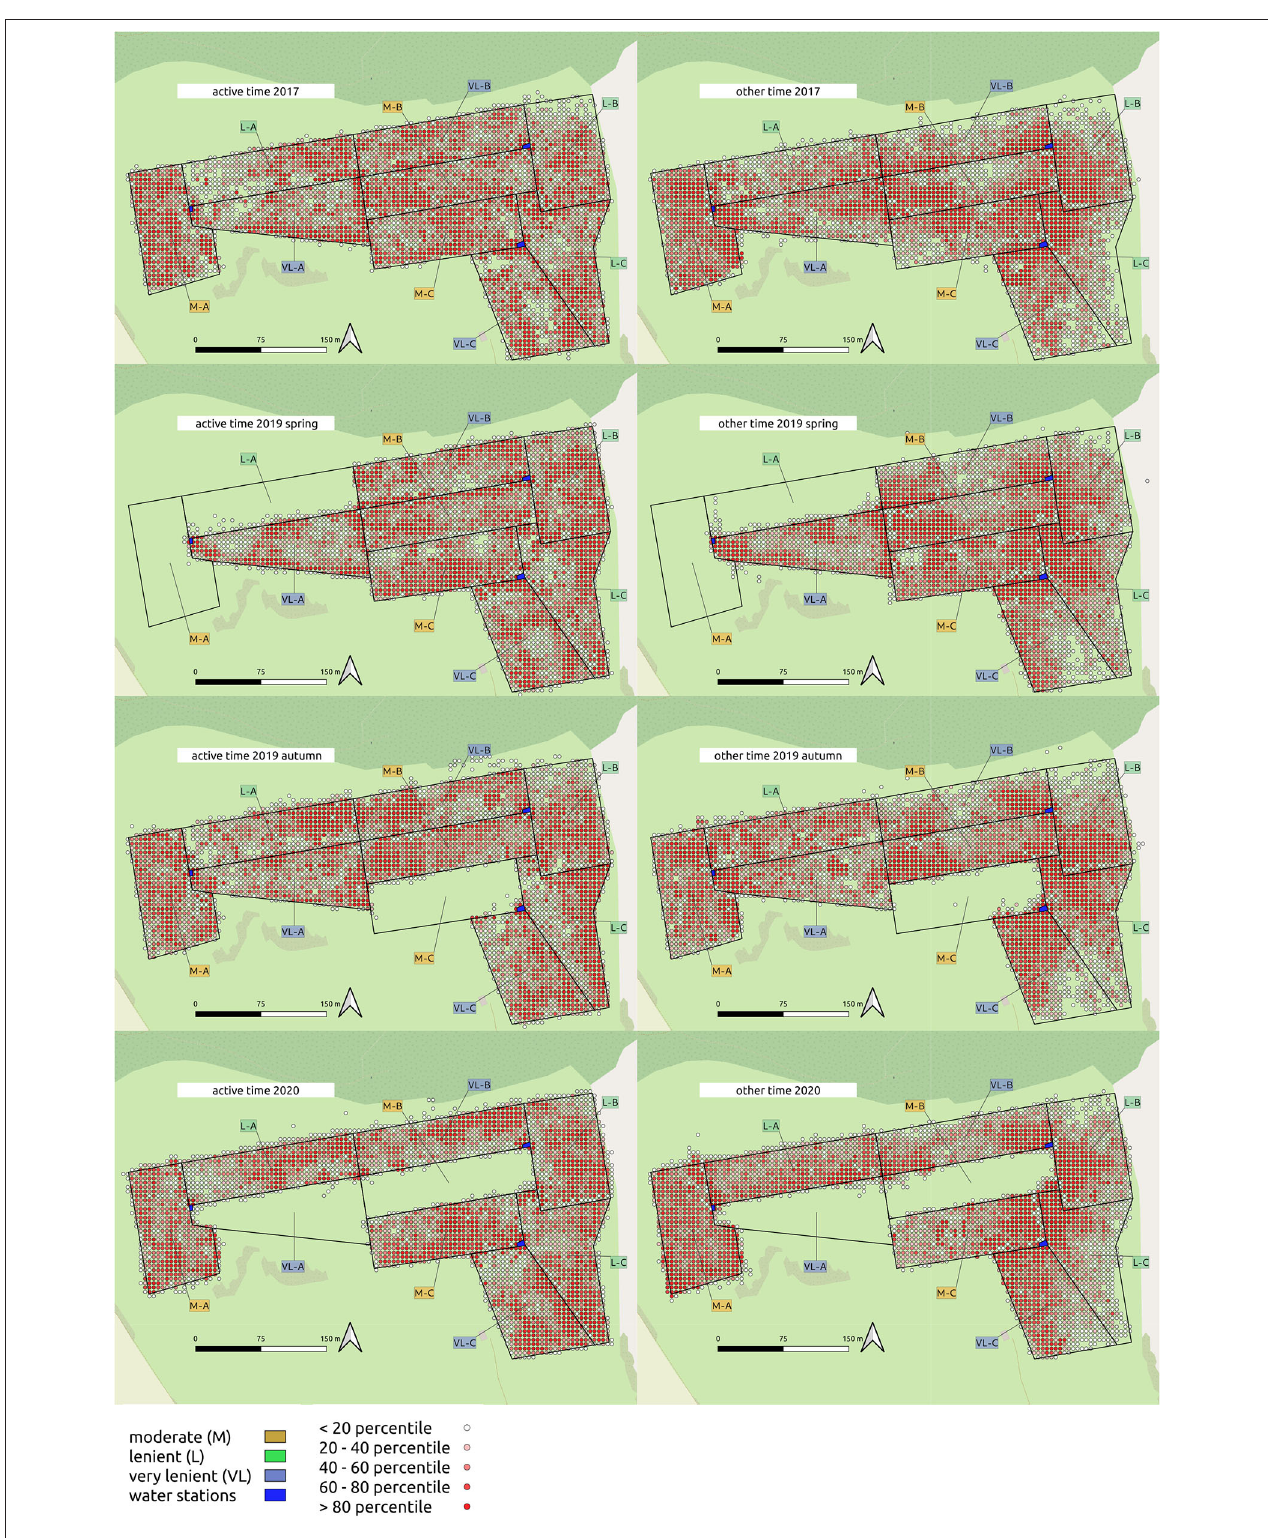
FIGURE 5 | Density maps of cattle location during active time/other time within 5 × 5m gridcells on the experimental site.